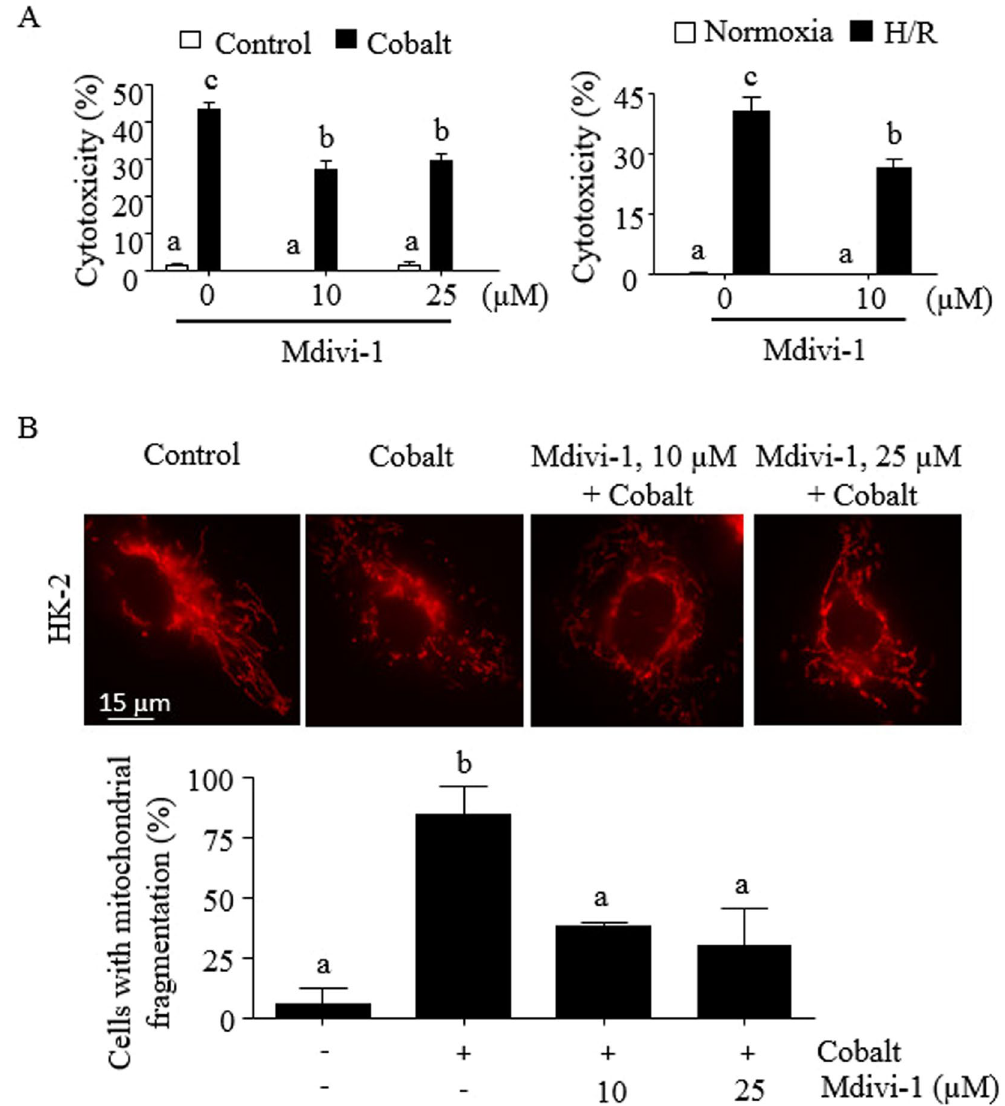
Figure 5. The DRP1 inhibitor Mdivi-1 protects HK-2 cells from mitochondrial fission and cytotoxicity induced by cobalt and H/R. ( A ) HK-2 cells were treated with cobalt (300 µ M) for 16 h (left panel) or incubated in the hypoxia chamber (0.2% O 2 , 5% CO 2 & 95% N 2 at 37 °C) for 24 h, followed by a standard cell culture incubator (~21% O 2 , 5% CO 2 & ~74% N 2 at 37 °C) for the next 16 h in the presence or absence of Mdivi-1. Cytotoxicity was measured by an MTT assay as described in “ Methods ”. ( B ) Similarly, HK-2 cells were treated with cobalt (300 µ M) in the presence or absence of Mdivi-1 for 16 h and stained with MitoTracker ® -Red. Cells were then visualized (600x magnification) and a representative image of 3 independent experiments is shown (top panel). A total of 30 randomly selected cells from each sample was evaluated for mitochondrial fission (bottom panel). ( A , B ) Data are expressed as mean ± S.D. [n = 3; p < 0.05 by one-way ANOVA with Tukey multiple comparison test; columns accompanied by the same letter are not significantly different from each